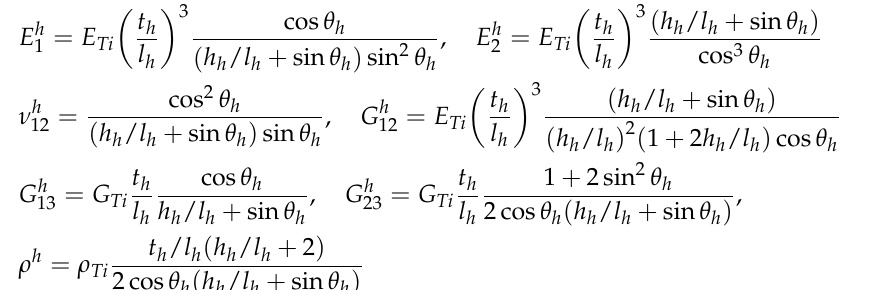
for ( θ 1 / θ 1 / θ 2 ) s 13 for (20/ − 20/ θ 2 ) s 13